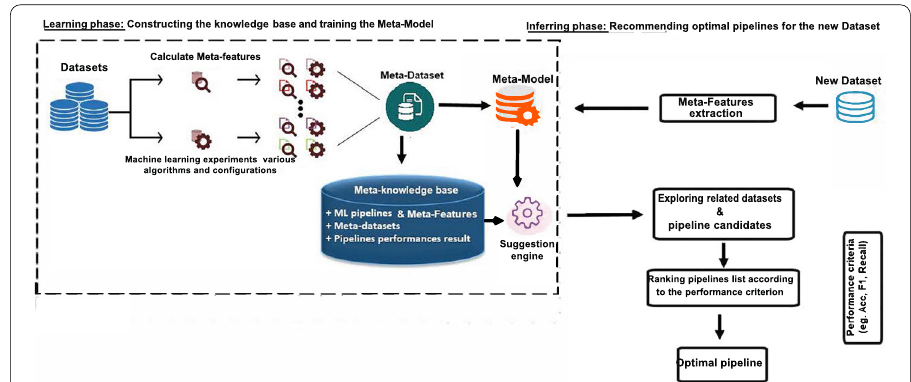
Fig. 1 The functional architecture and process flowchart of